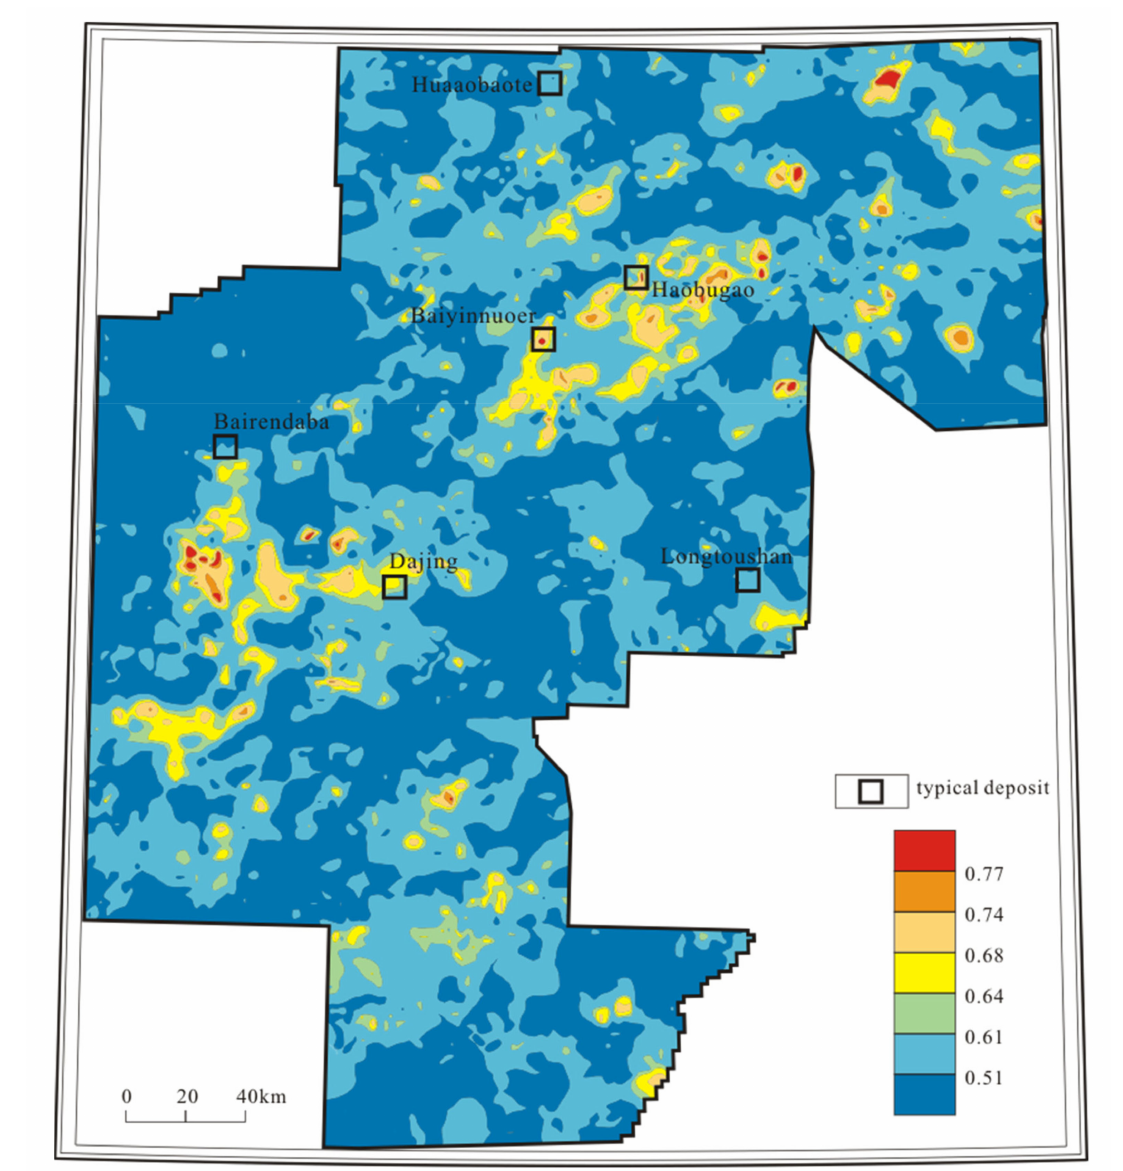
Figure 3. The contour map of the similarity coefficients with the Baiyinnuoer Pb–Zn